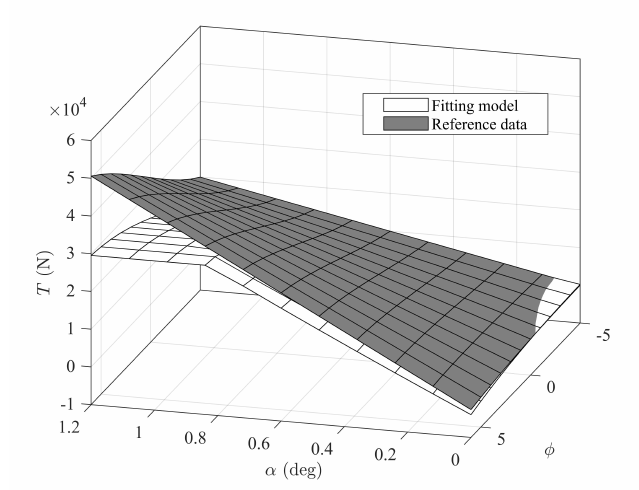
Figure 3. Comparison diagram for the propulsive